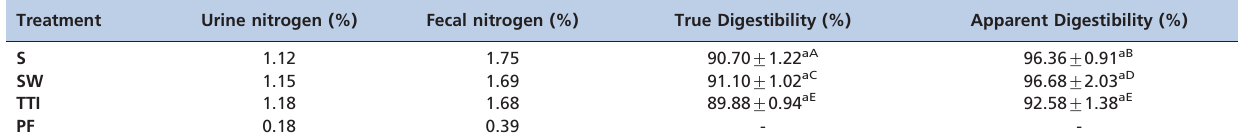
Table 1 - True digestibility and apparent digestibility in Wistar rats subjected to the standard diet AIN-93G (S, n= 6), AIN- 93G + 1 mL of water (SW, n= 6), AIN-93G + 25 mg/kg tamarind trypsin inhibitor in 1 mL water (25 mg/kg TTI, n= 6) and protein-free diet (PF, n = 6) for 11 days. The results are expressed as the mean ¡ standard deviation in each group. Different lower case letters indicate p , 0.05 between groups. Different upper case letters indicate p , 0.05 between true digestibility and apparent digestibility. One-way ANOVA followed by Tukey’s post-hoc test or Student’s t-test was used.